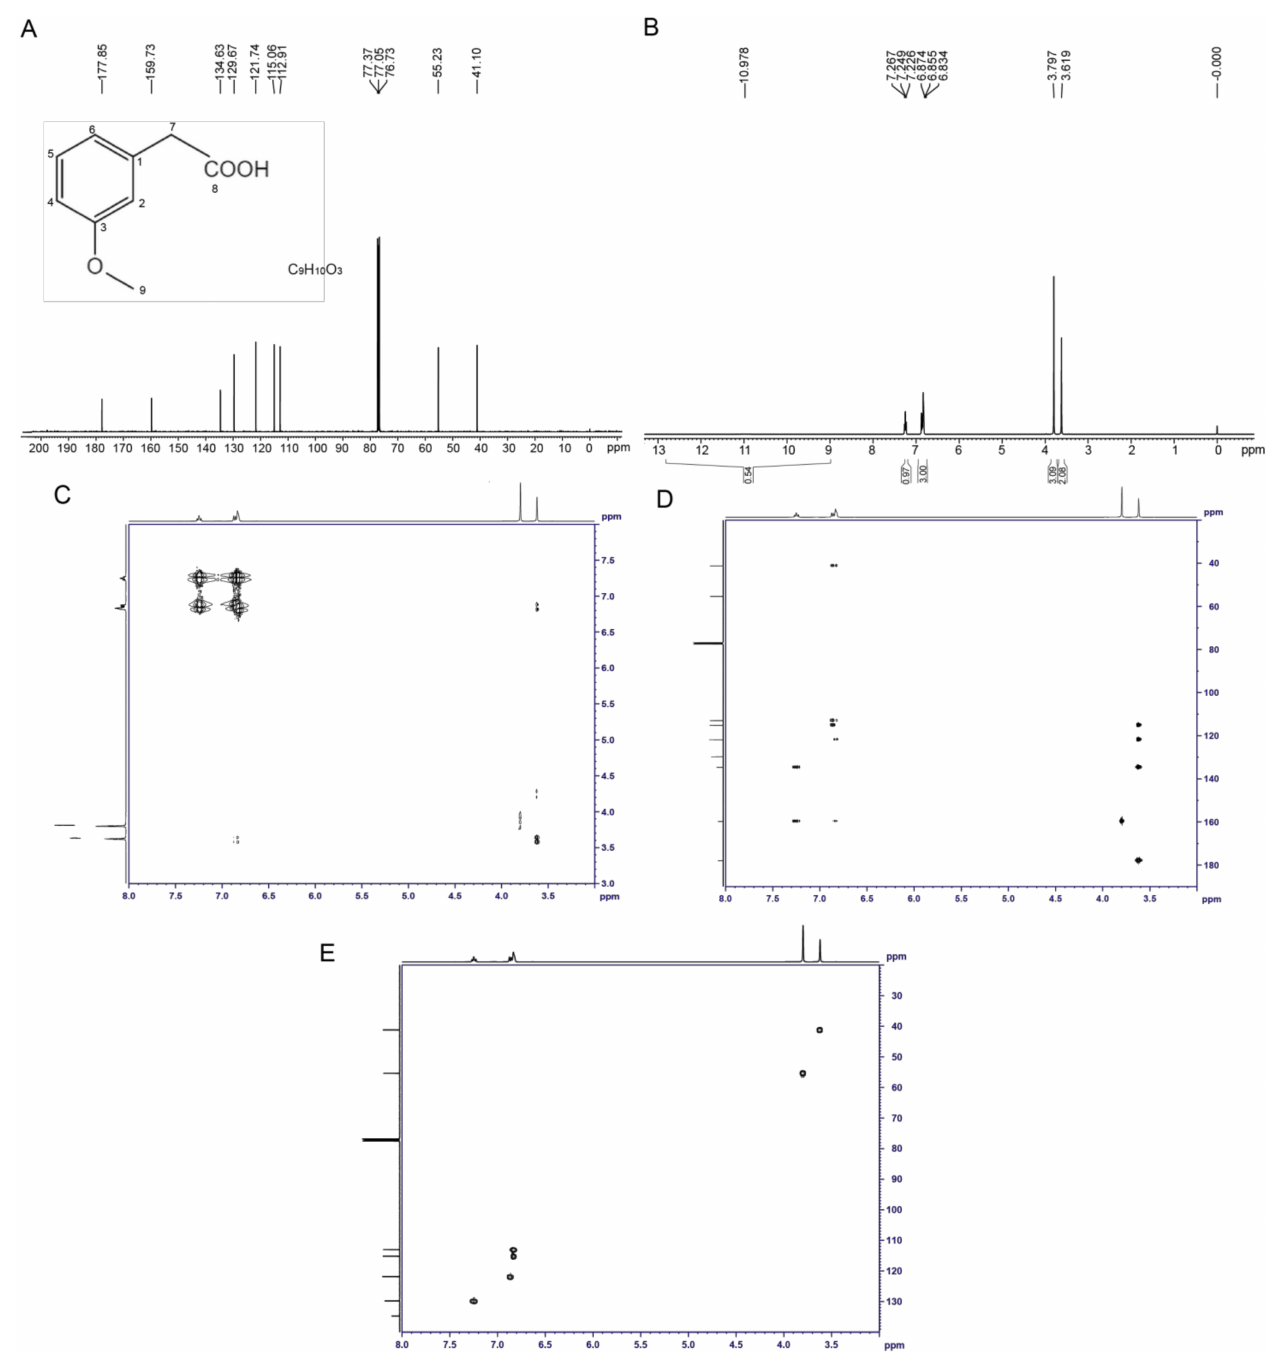
Figure 4. Identification of the structure of the toxin compound from R. solani AG-3 TB. ( A ) The 1 H-NMR analysis of the structure of the toxin. ( B ) The 13 C-NMR analysis of the structure of the toxin. ( C ) COSY NMR spectrum of the toxin compound. ( D ) HMBC NMR spectrum of the toxin compound. ( E ) HSQC NMR spectrum of the toxin